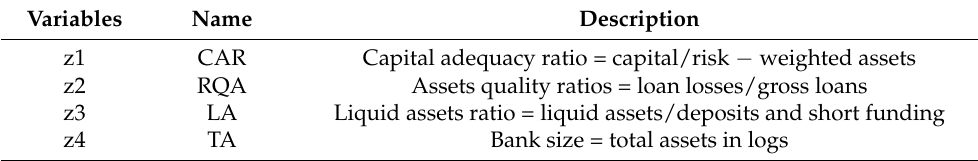
Table 2. Definition of control variables.